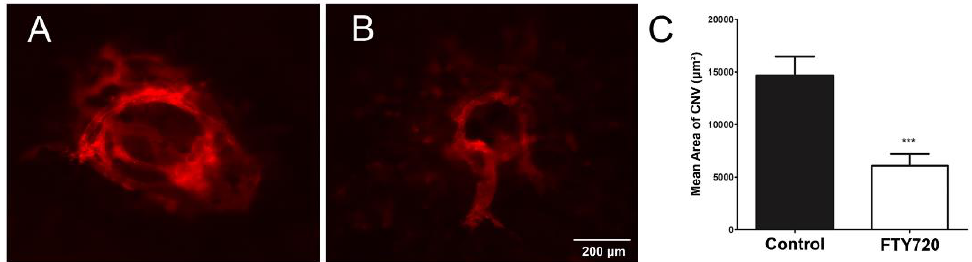
Figure 8. Oral delivery of the S1PR agonist FTY720 inhibits CNV in a mouse model of nAMD. Ve- hicle control ( A ) or FTY720 ( B ) was administered orally (0.3 mg/kg body weight) to C57BL/6j male